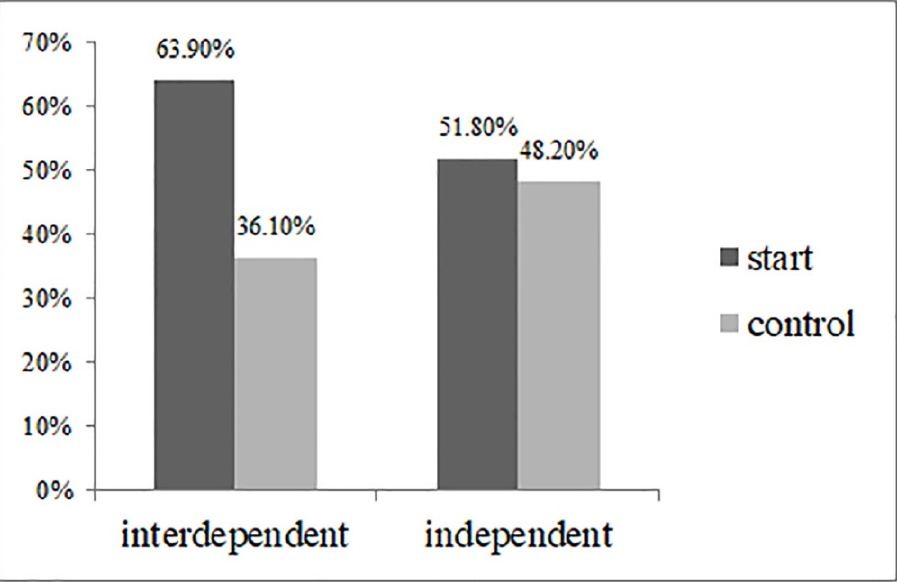
Figure 2. High ‐ arousal music preferences (Study 2). Table 5. Statistics descriptive results in Study